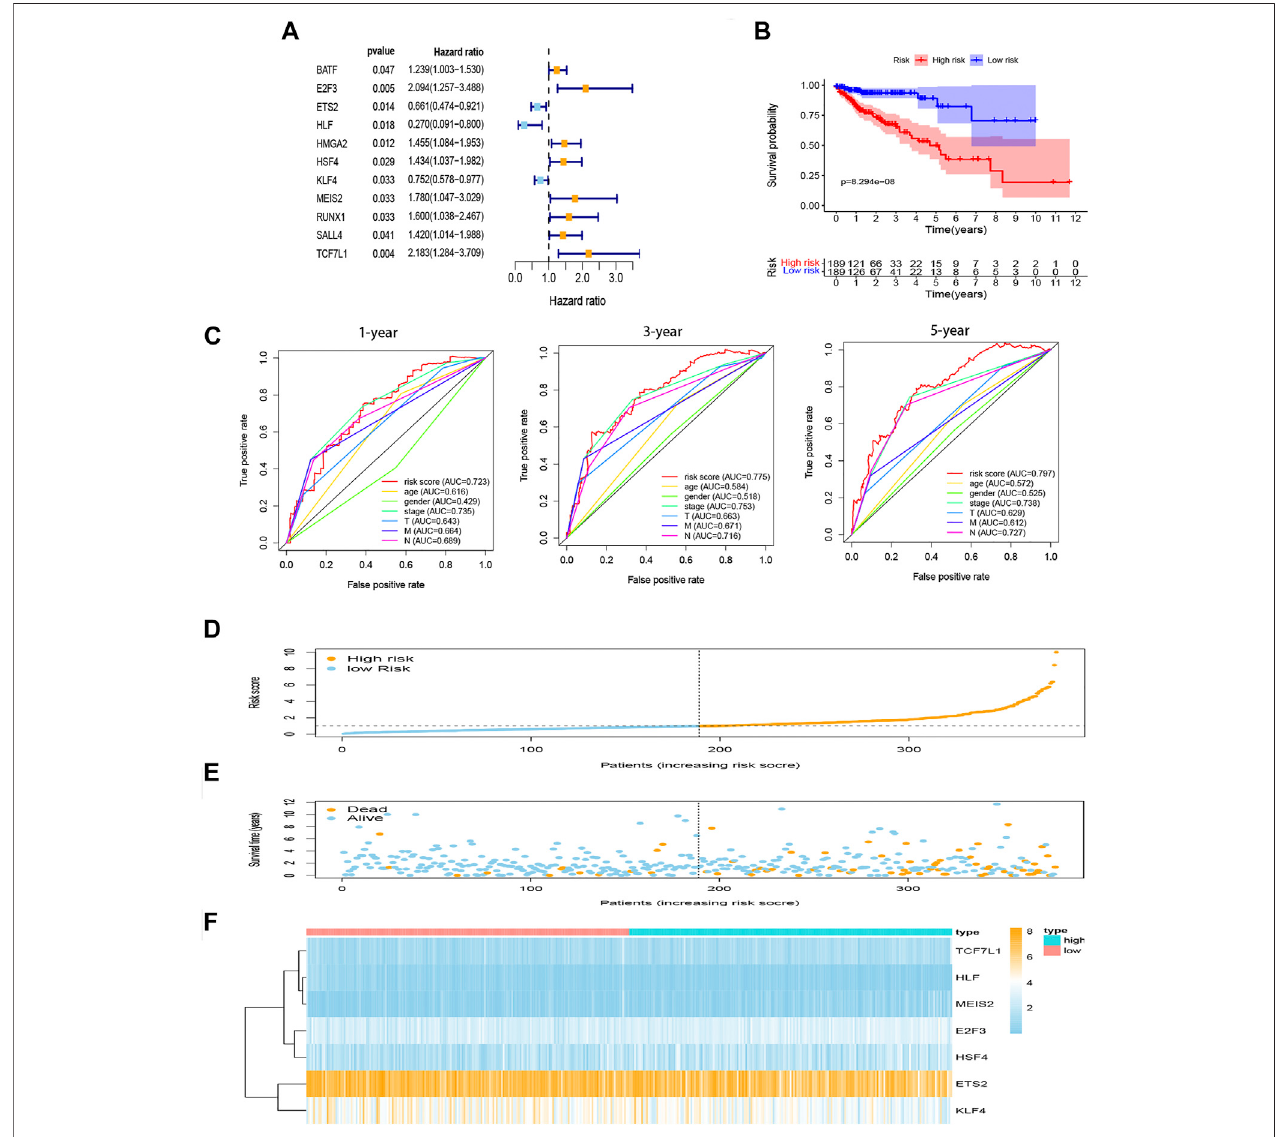
FIGURE 3 | Construction of prognostic model for COAD. (A) Hazard ratio of univariate Cox analysis for DEGs. (B) Survival analysis to verify the prognostic model. (C) ROCcurvetoevaluatethepredictiveef fi cacyoftheriskmodel. (D) DistributionofriskscoresofeachCOADpatient. (E) Correlationbetweensurvivaltimeandsurvival status of each patient. (F) The expression pattern of seven TF-related genes. DEGs, differentially expressed genes. ROC, receiver operating characteristic.